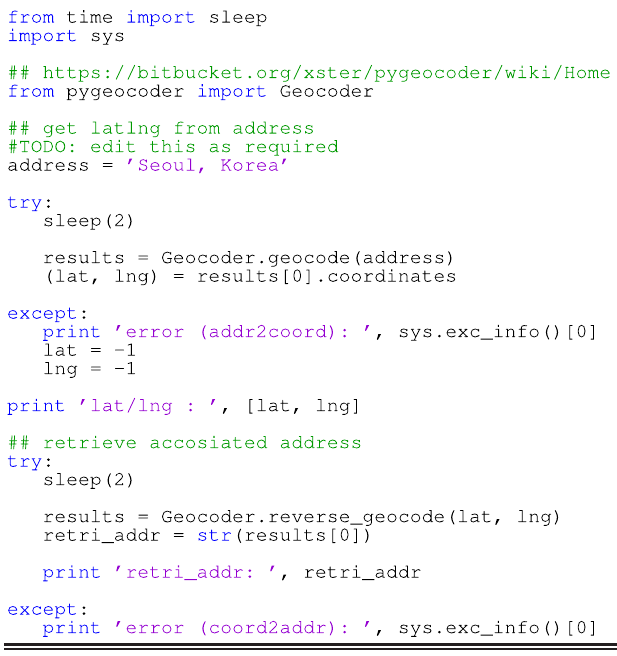
regions by searching for the name of the administrative TABLE IV. P YTHON code to obtain location coordinates in